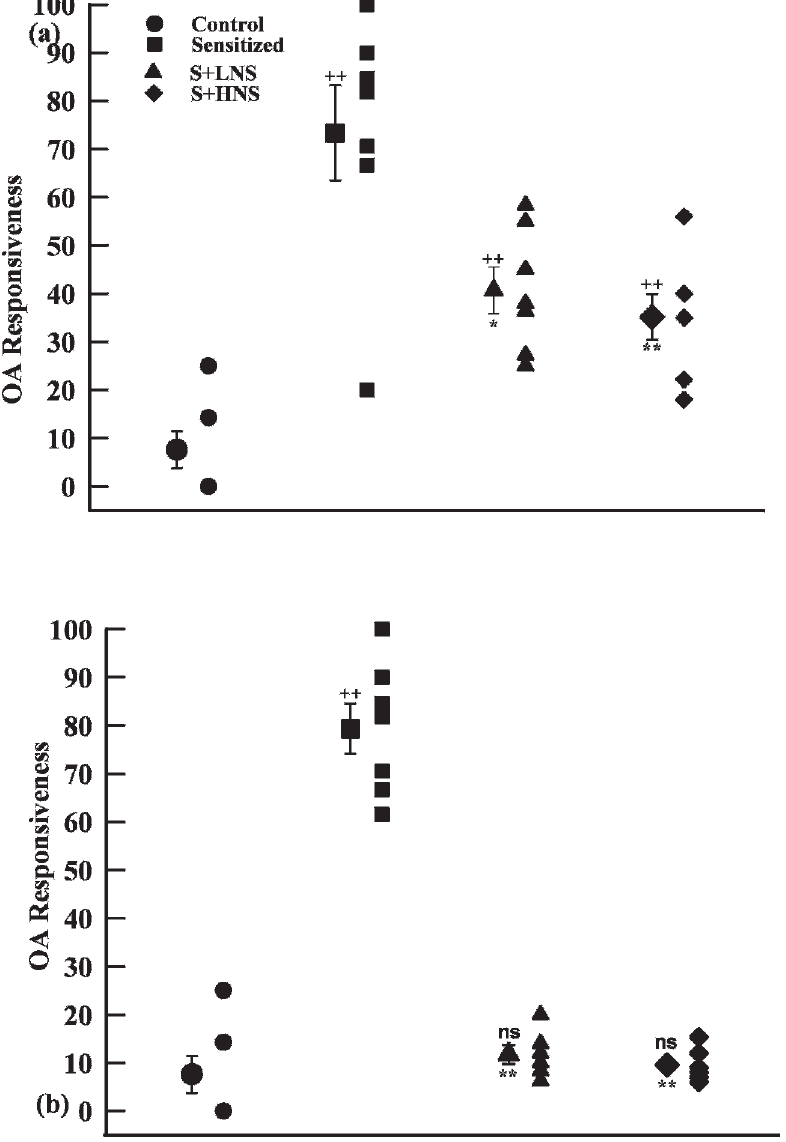
Figure 4 - Individual values and mean ¡ SEM (larger symbols with bars) of the tracheal response to ovalbumin in the absence (a) or presence of 0.25 g% N. sativa extract (b; for each group, n =7). The data are presented as the percent contraction in proportion to the contraction obtained following treatment with 10 m M methacholine. Statistical differences between the control and different groups: ns; non-significant difference, ++ ; p , 0.01. Statistical differences between S + LNS and S + HNS vs. sensitized group: *: p , 0.05, **: p , 0.01. There was no significant difference in the effects of the two different concentrations of